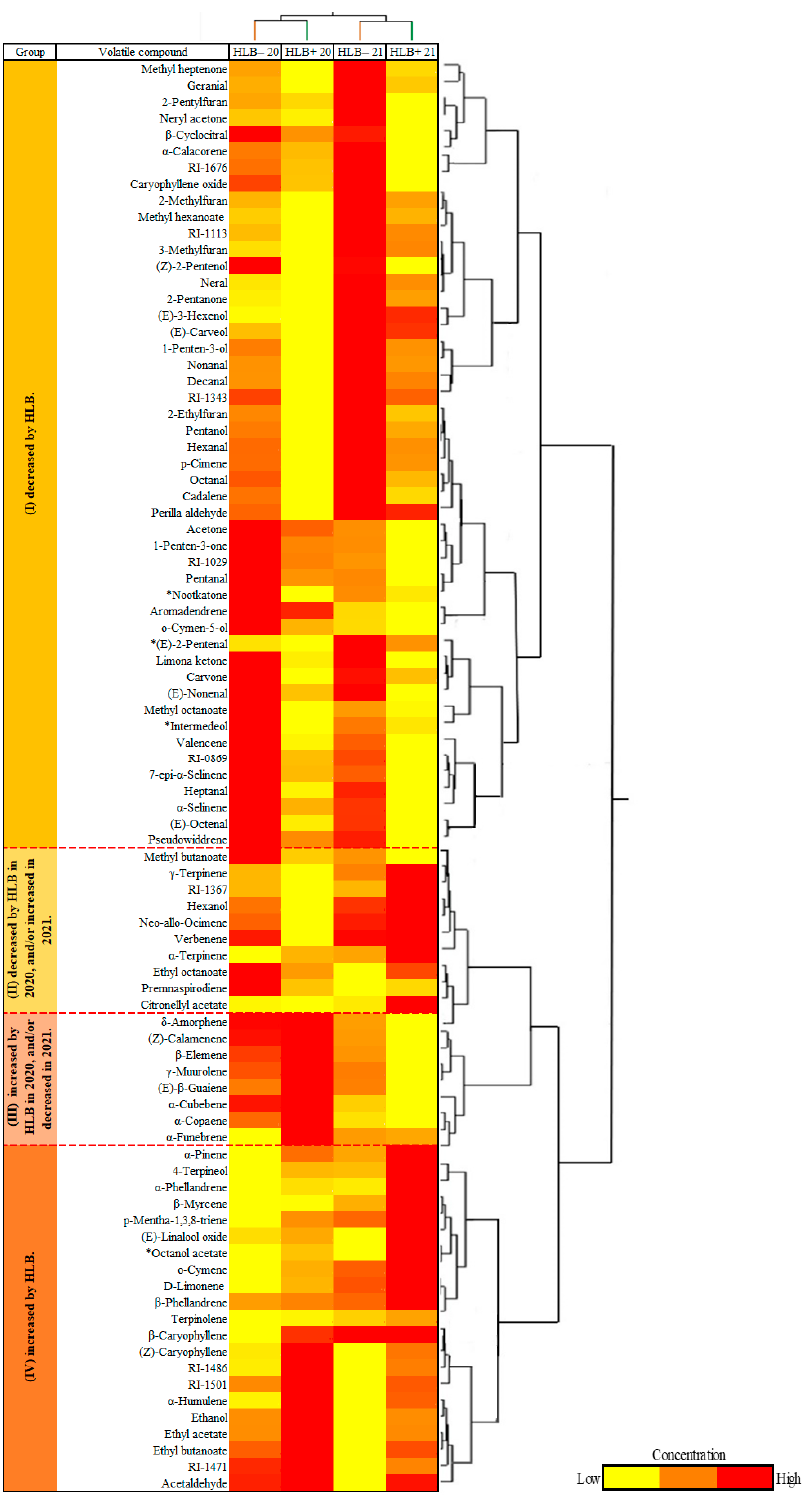
Figure 5. Combined cluster analysis and heat map of investigated grapefruit juice samples of healthy (HLB − ) and HLB-affected fruits (HLB+) from 2020 (HLB − 20 and HLB+ 20) and 2021 (HLB − 21 and HLB+ 21) harvests (columns) and identified VOCs (rows). Chemical groups increased and/or decreased by Huanglongbing (HLB) determined the average concentration of volatiles in juice extracted from ‘Ray Ruby’ grapefruit in two harvest seasons, 2020 and 2021. * Significant differences at p ≤ 0.05 according to Tukey’s HSD test in both years.